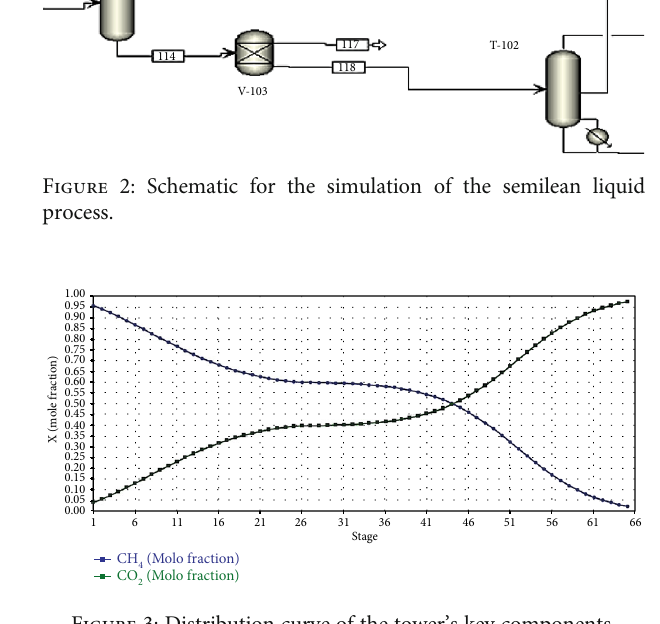
Figure 3: Distribution curve of the tower ’ s key